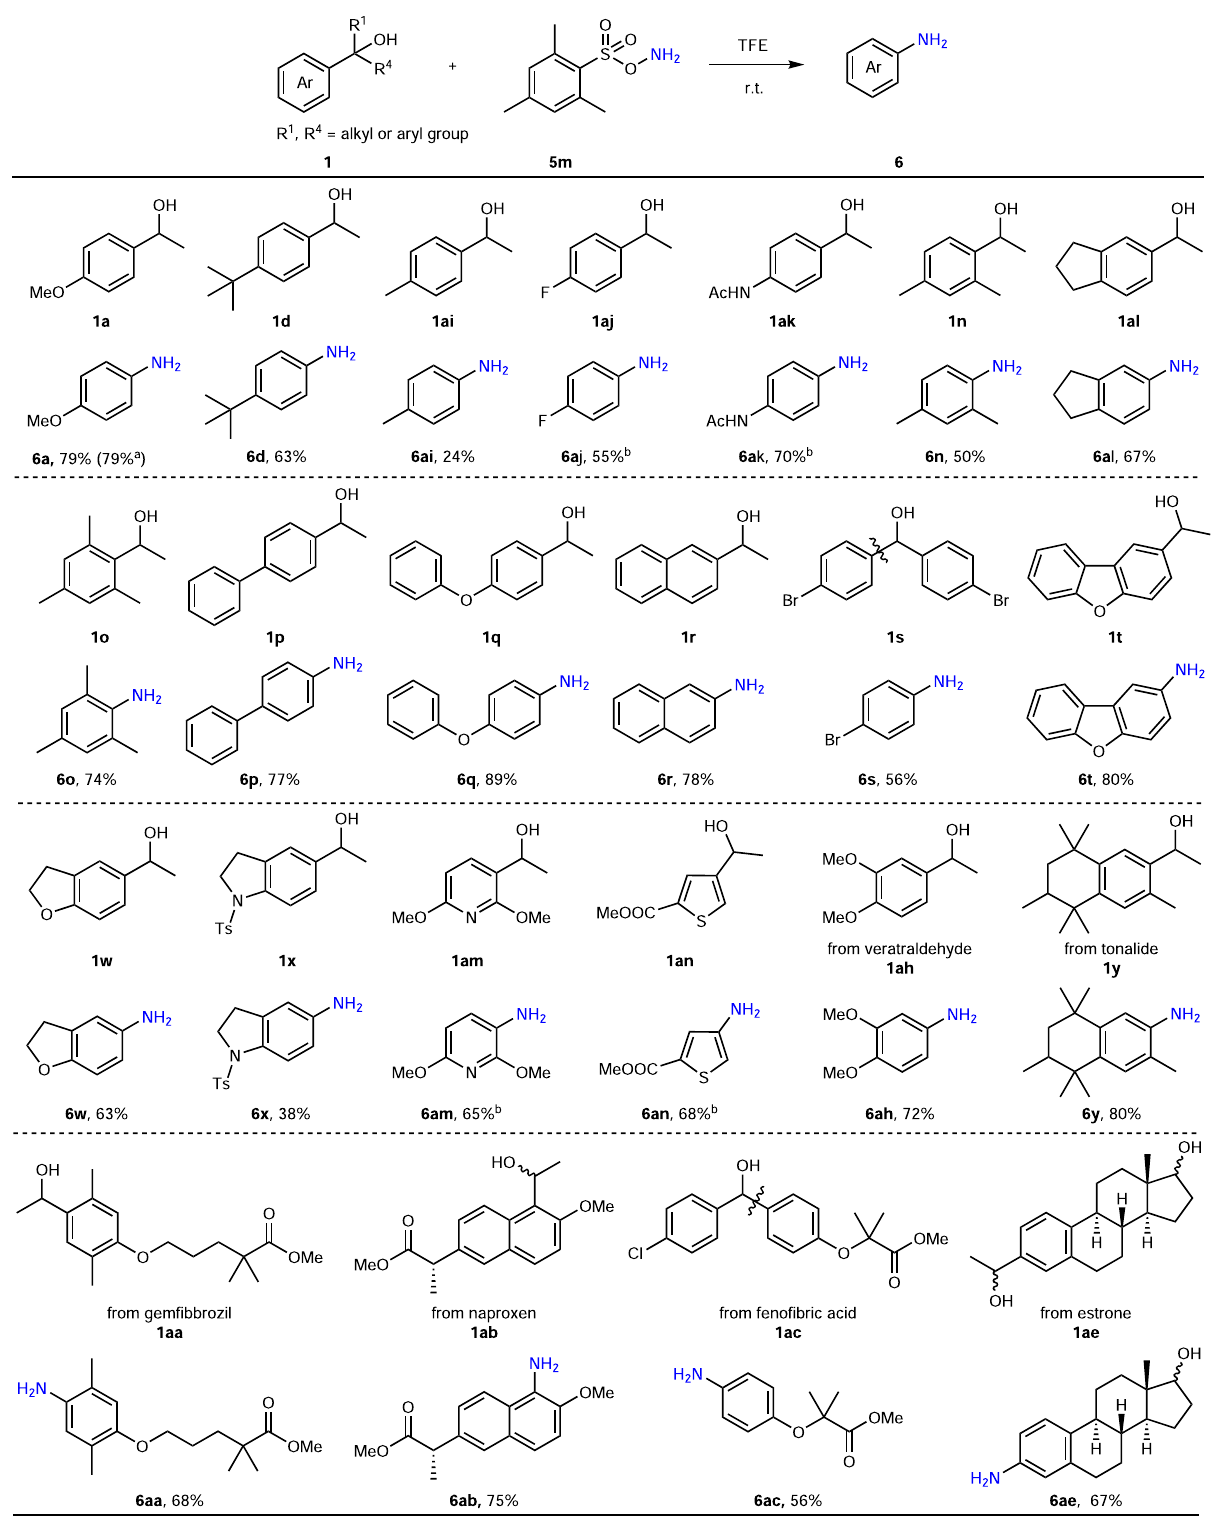
Fig. 5 Scope with regard to the alcohol in the synthesis of primary anilines. Reaction conditions: alcohol (0.2mmol), 5m (0.3mmol), TFE (tri fl uoroethanol) (1mL), 12h, r.t.; a 1a (4mmol), 5m (6mmol), TFE (20mL); b HFIP (hexa fl uoroisopropanol) (1mL) was instead of TFE (1mL); Ac acetyl, Ts